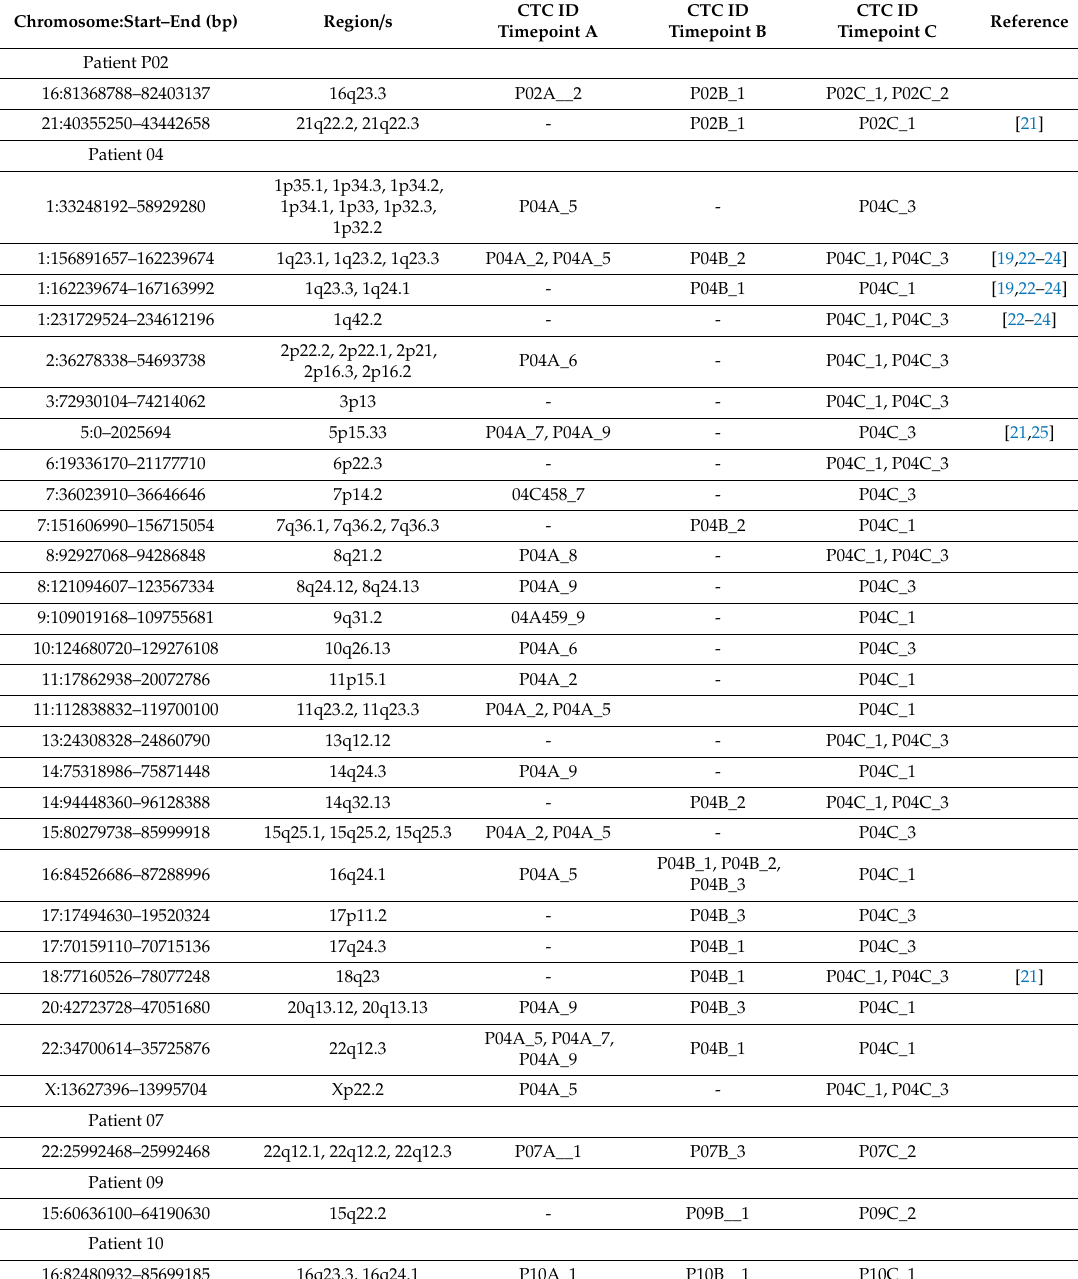
Table 2. List of the altered regions in tumor tissue and in at least two CTCs of the same patient isolated at all access